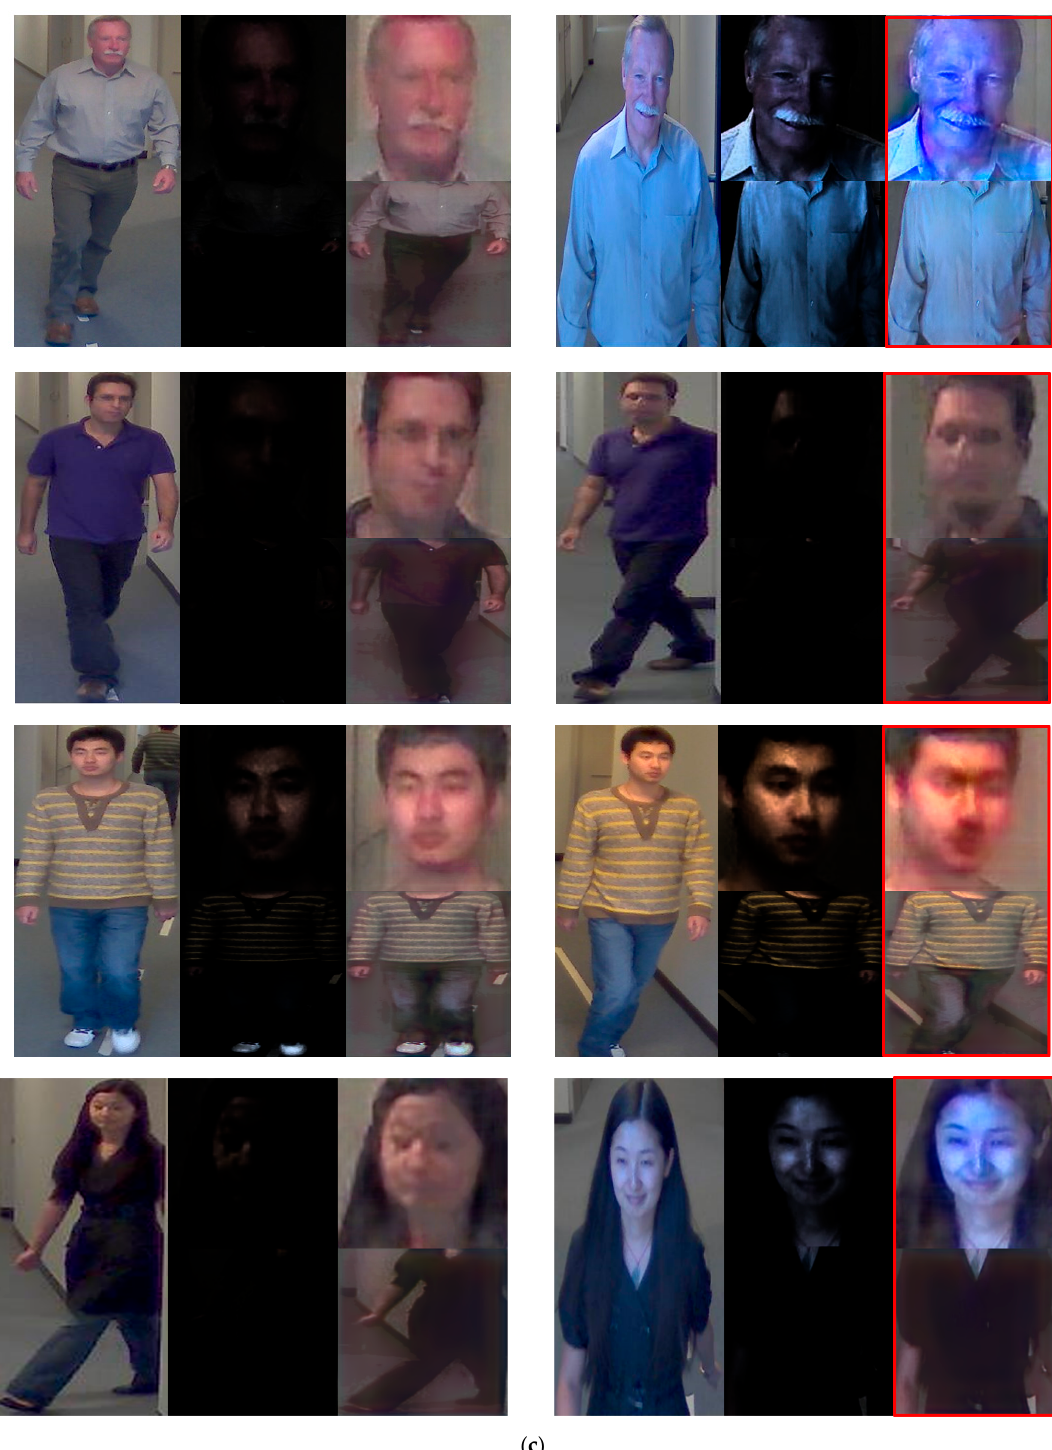
Figure 20. Cases of FA, FR, and correction recognition on ChokePoint database [34]. ( a ) Cases of FA, ( b ) cases of FR, and ( c ) correct cases. In ( a – c ), the left and right images are enrolled and recognized images, respectively.